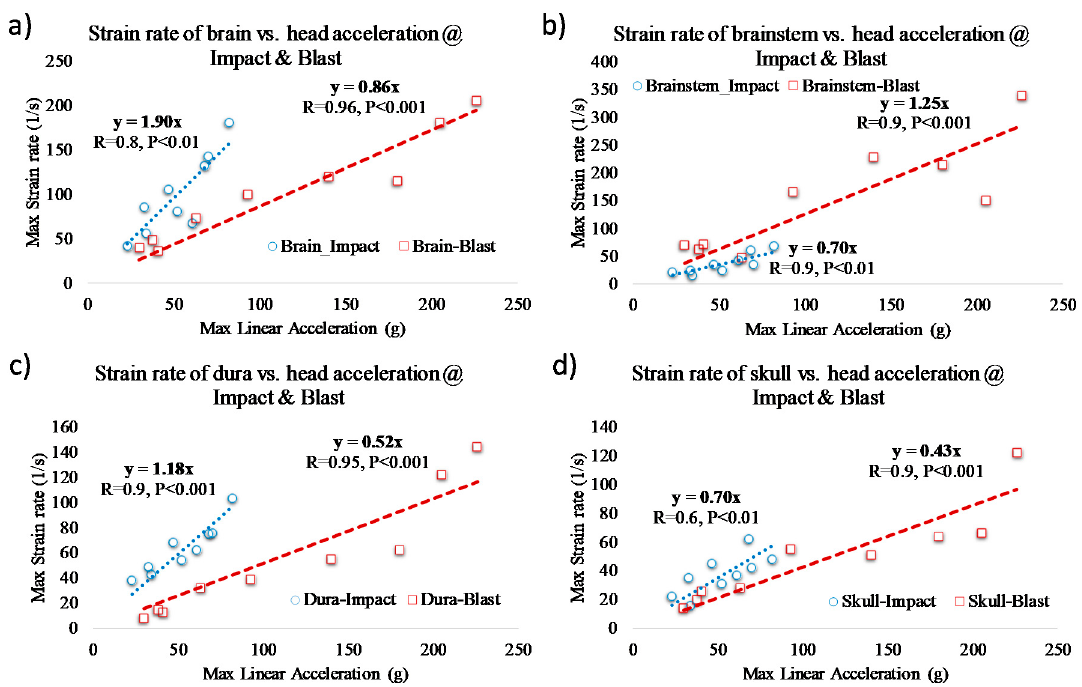
Figure 9. Linear regression of highest evaluated strain rate versus maximum acceleration of head under impact and blast cases for: ( a ) brain, ( b ) brainstem, ( c ) dura, and ( d ) skull.